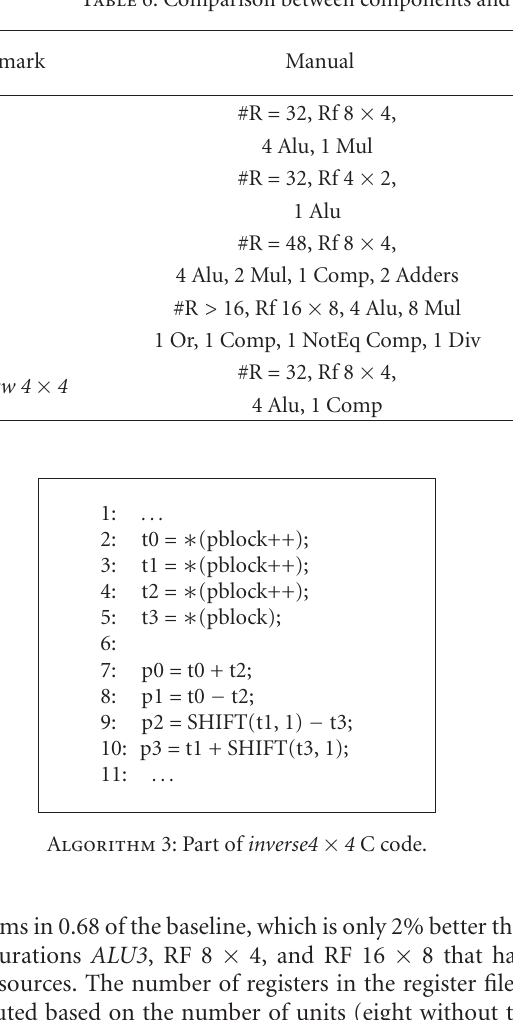
Table 6: Comparison between components and parameters of manual and automatically generated design.